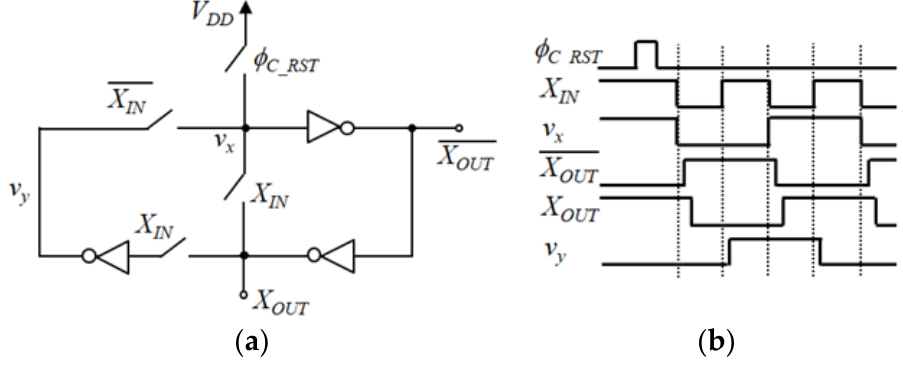
Figure 4. One-bit counter used in the unit cell circuit of Figure 2: ( a ) schematic diagram; ( b ) timing diagram.